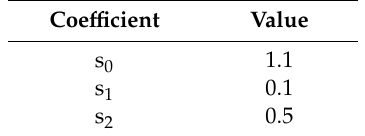
Table 2. Coe ffi cients of the damage model in Equation